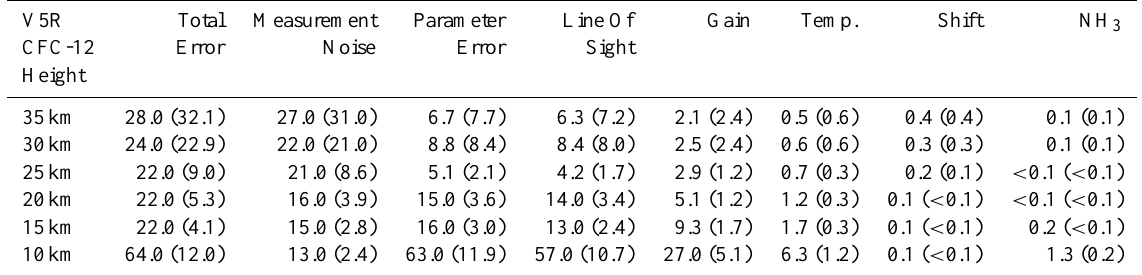
Table 7. Error budget of a V5R CFC12 220 (RR nominal mode) retrieval from spectra recorded at 37 ◦ N, 29 ◦ W on 19 September 2009 at 00:11 UTC, for selected altitudes. The errors are given in units of pptv(%). Details as for Table 2. V5R